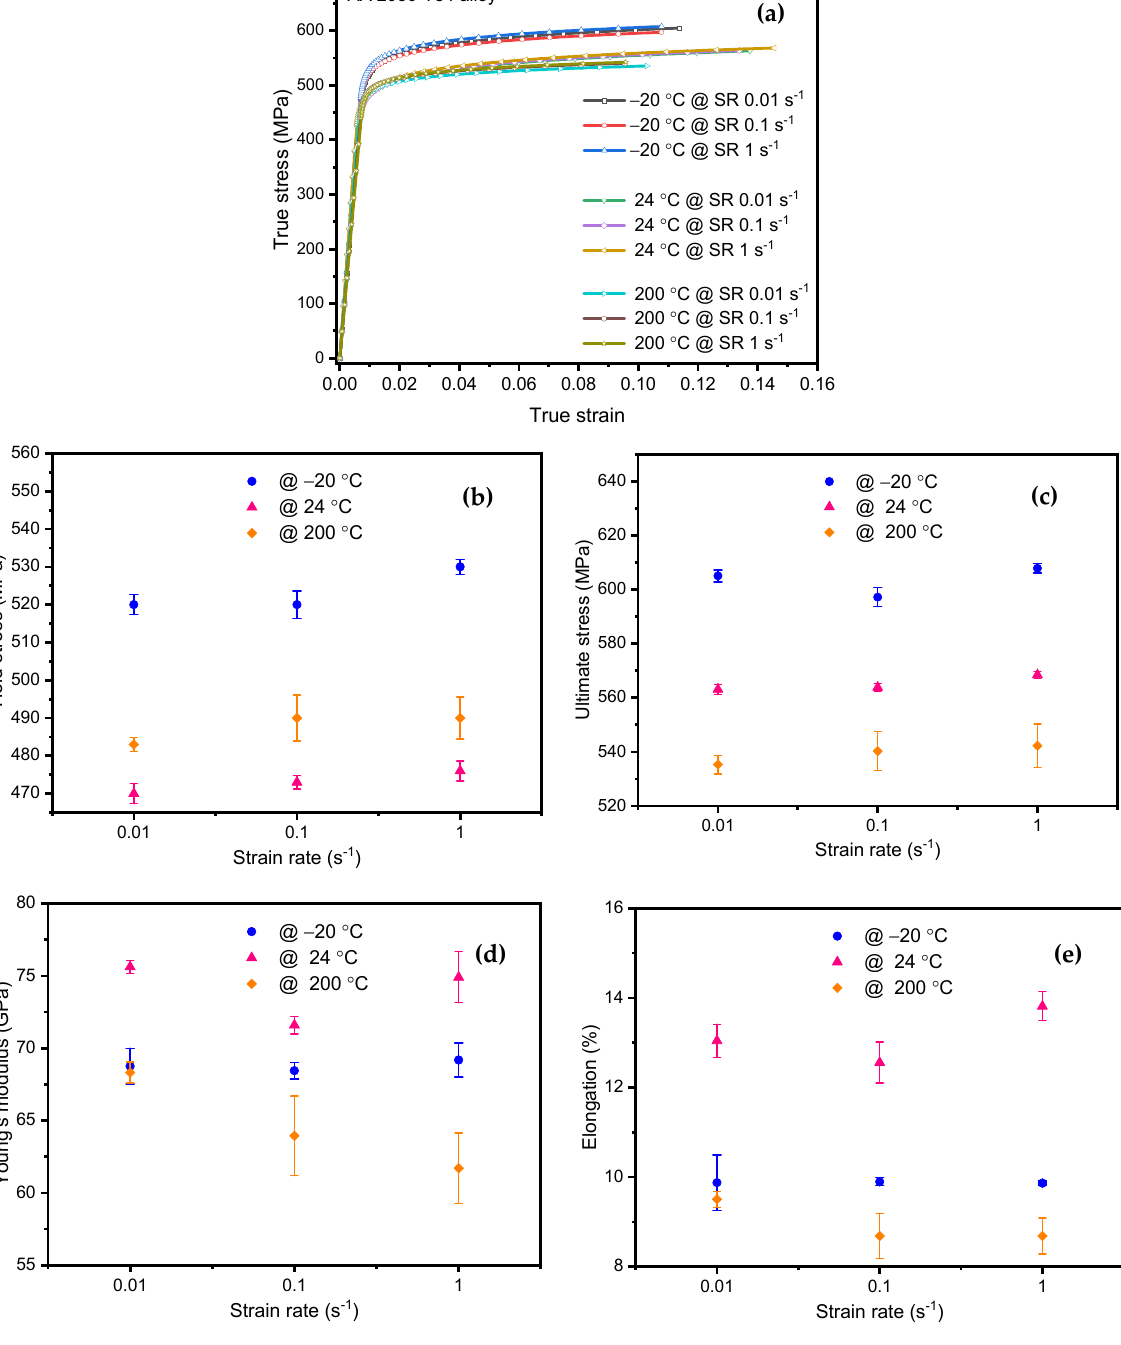
Figure 4. Strain rate and Temperature effect on: ( a ) True stress-strain curves ( b ) Yield stress; ( c ) Ultimate stress; ( d ) Young’s modulus; ( e ) elongation.